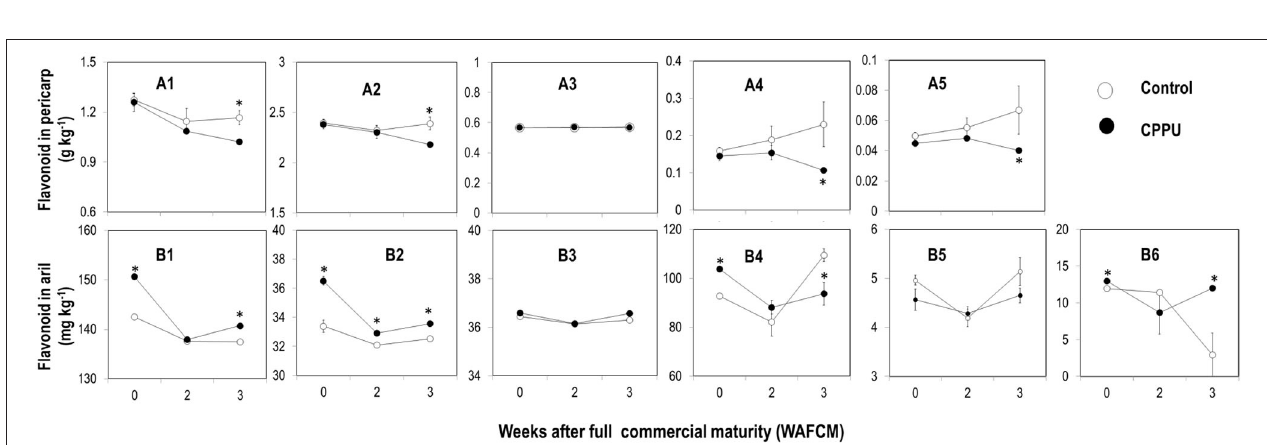
FIGURE 4 | Effect of CPPU treatment on content of malondialdehyde (MDA) in the pericarp. Vertical bar at each data point stands for standard error ( n = 5). *Indicates significant difference between CPPU treatment and the control at p < 0.05, Student’s t -test.